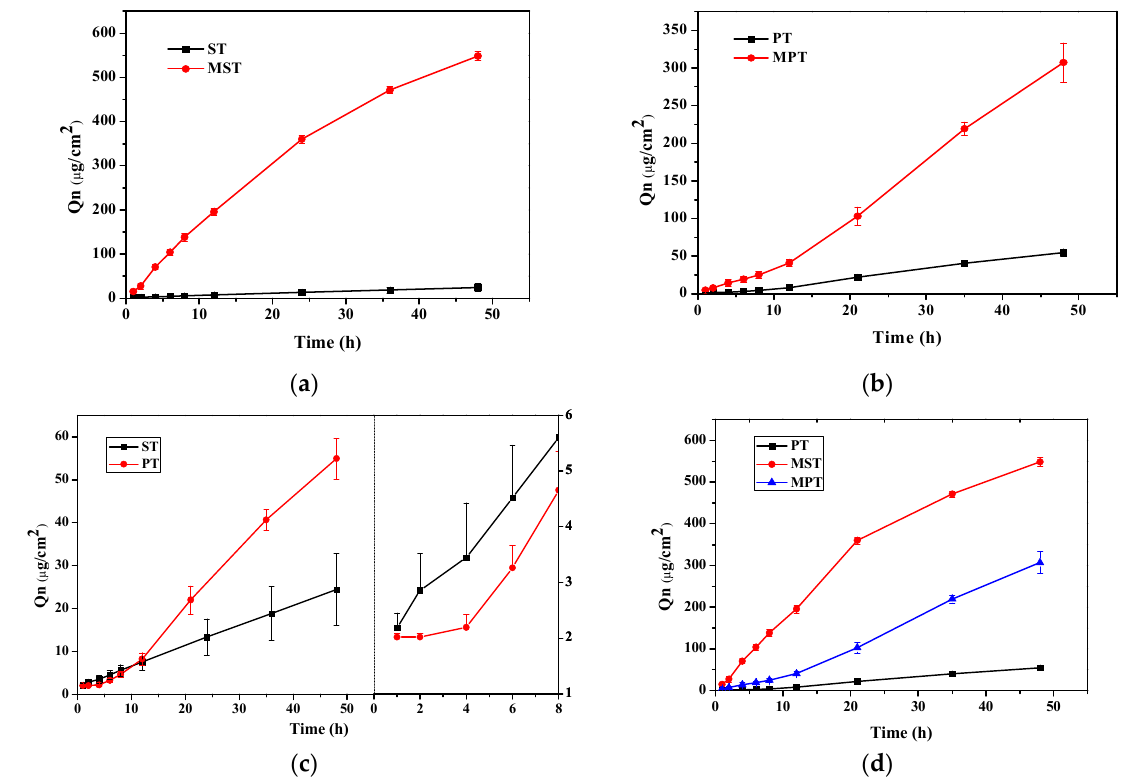
Figure 6. Cumulative ex vivo skin permeation ( a ) TGP-S and MN-assisted TGP-S; ( b ) TGP-E and MN-assisted TGP-E; ( c ) TGP-S and TGP-E; ( d ) TGP-E, MN-assisted TGP-S and MN-assisted TGP-E ( n =